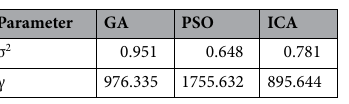
Table 2. Detailed information about trained